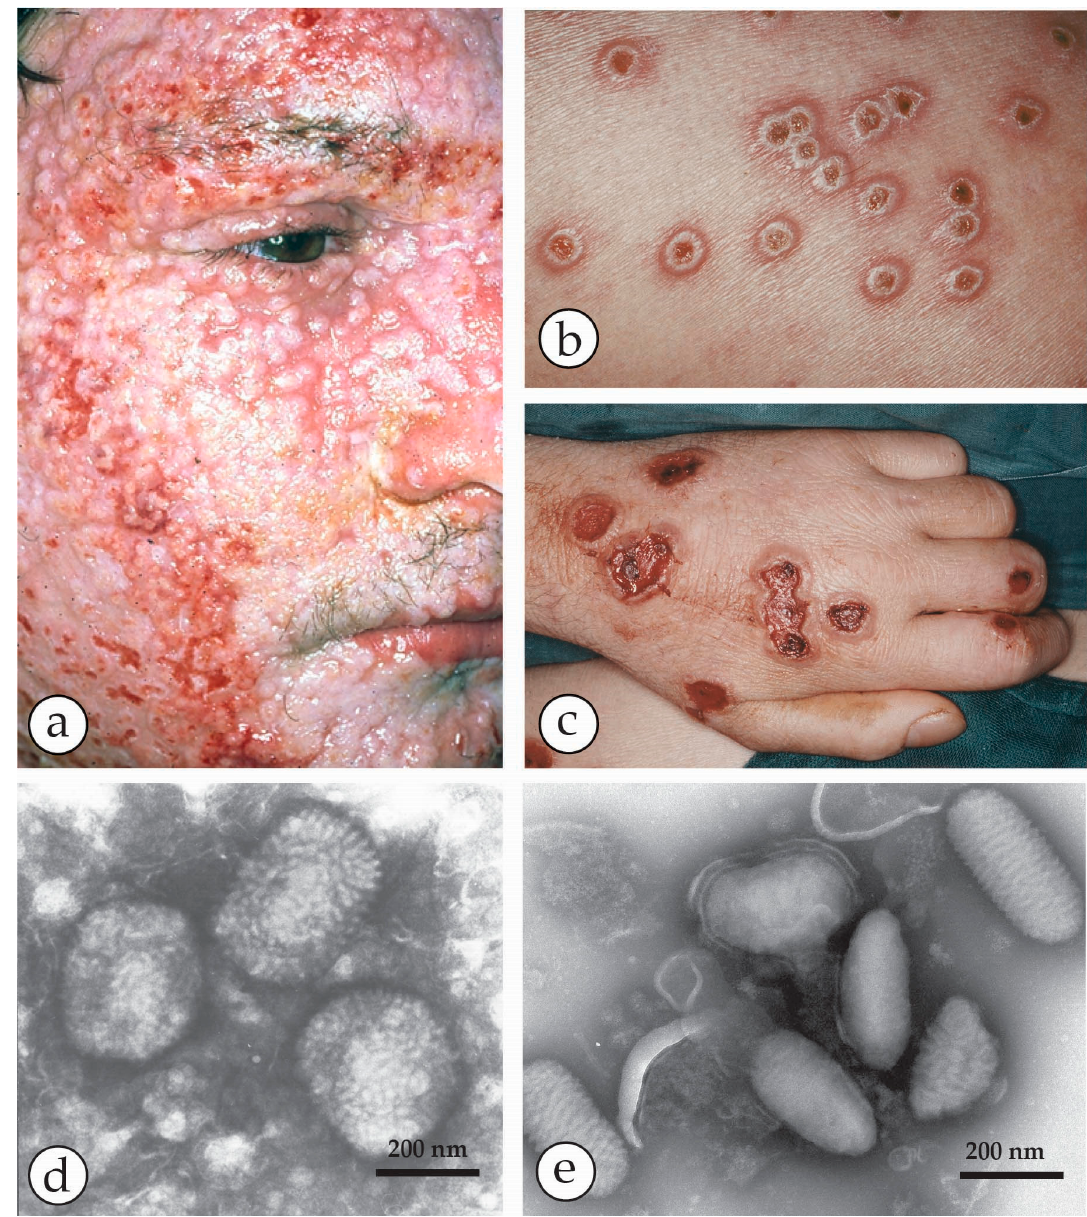
Figure 3. A fatal case of a cowpox zoonosis: ( a – c ) A zoonotic CPXV infection in an 18 year old immuno-compromised man. He was under massive steroid therapy for an allergy. The patient took care of a stray cat and developed fever and a generalized rash 10 days later. Vesicles developed into hemorrhagic pustules ( b ) with a tendency to fuse into larger ulcers ( c ). The patient died with circulatory collapse. ( d ) NS-DEM of specimens with PTA revealed brick-shaped particles with short surface threats typical of OPV. ( a – d ) reprinted from [33], with kind permission of Drs. Anna M. Eis-Hübinger and Bernhard Pfeiff and Springer Nature. ( e ) For comparison Parapoxviruses (PPV) after NS: smaller than OPV, ovoid and surrounded by long parallel spiral surface threads.